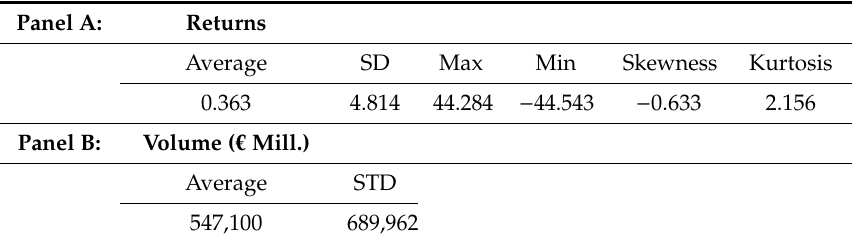
Table 1. Summary statistics for the sample of mutual funds 1